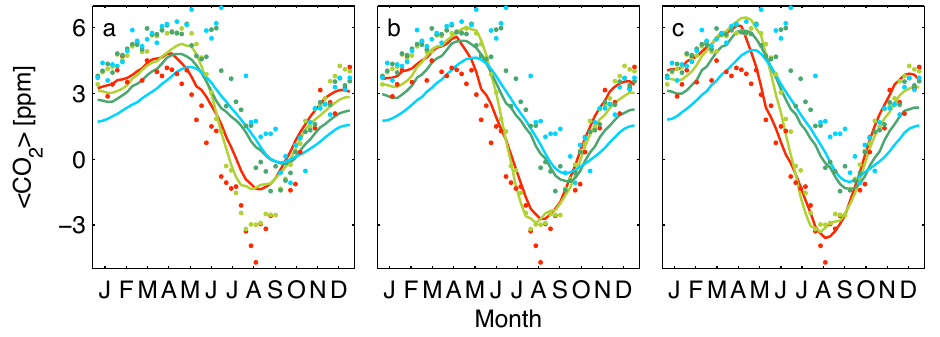
Fig. 12. Detrended weekly median h CO 2 i at four Northern Hemisphere TCCON sites (circles) plotted with simulated h CO 2 i from AM2 (solid lines). The simulated CO 2 has been smoothed using a two week running mean. The observed and simulated h CO 2 i values are referenced to annual mean h CO 2 i at Lauder, New Zealand. In each panel, the data are the same, while the simulated seasonal cycles result from (a) CASA net ecosystem exchange, (b) boreal amplified CASA net ecosystem exchange, (c) boreal amplified CASA net ecosystem exchange with an early growing season onset. CASA NEE underestimates the seasonal cycle amplitude in the column at all four sites, while simulations with enhanced boreal exchange better match the data. The colors are the same as in Fig. 1.